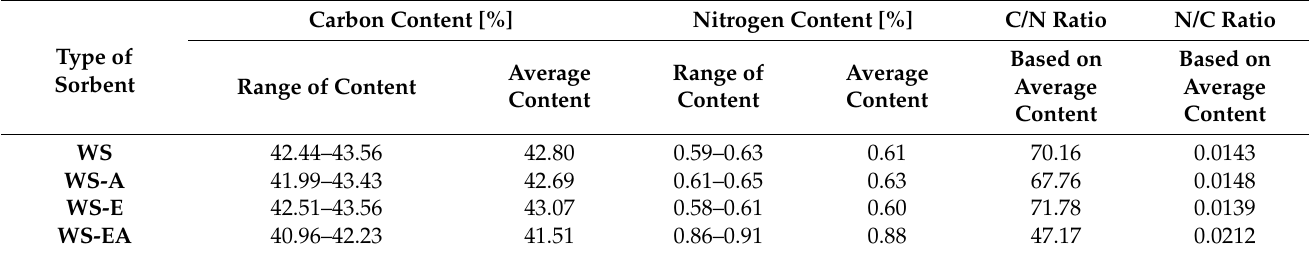
Table 2. Carbon and nitrogen content in tested sorbents. Analyses carried out on the elemental analyzer—FLASH 2000 (THERMO SCIENTIFIC, USA) (three repetitions of